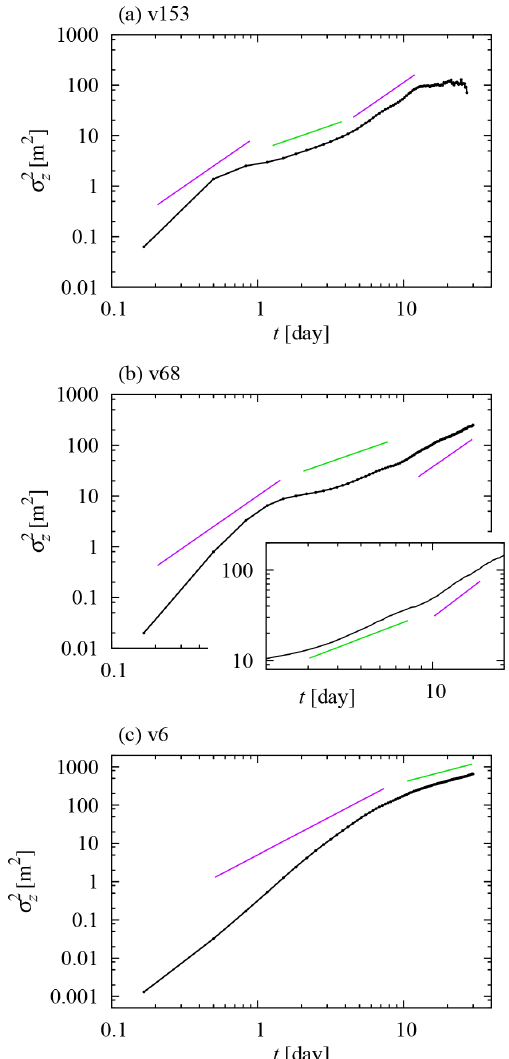
Figure 7. Variance of depth reached by the particles as a function of time. Straight lines represent power laws for reference, with ex- ponents 1 (in green, corresponding to standard diffusion) and 2 (in purple, corresponding to ballistic dispersion).